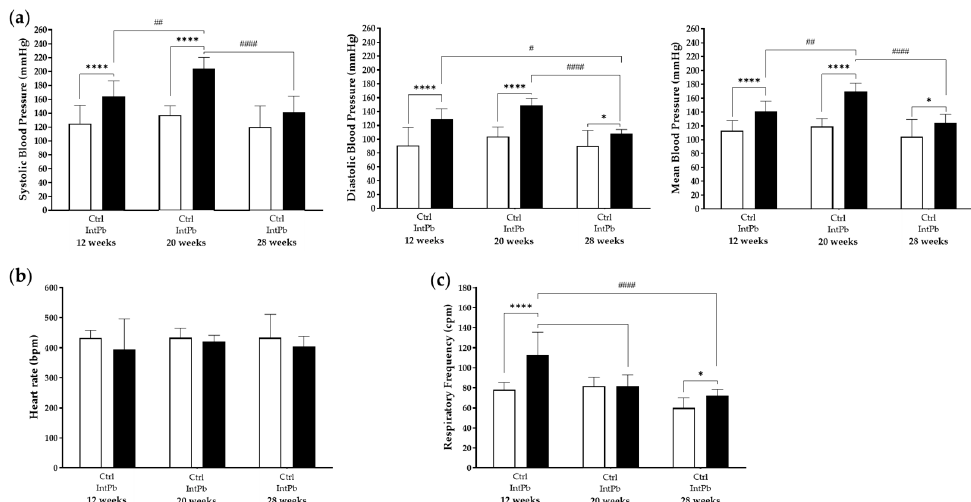
Figure 3. Cardiovascular and respiratory parameters evaluated along the three timepoints. ( a ) Systolic, diastolic, and mean blood pressure assessed from the femoral artery. ( b ) Heart rate values were calculated from the electrocardiogram. ( c ) Respiratory rate calculated from basal tracheal pressure. Values are expressed as the mean ± SD for n IntPb = 12 and n Ctrl = 12 for each evaluated time ‐ point. The symbols denote statistically significant differences inter (Ctrl vs. IntPb—* p < 0.05; **** p < 0.001) and intra groups (IntPb 12w vs. IntPb 20w vs. 28w—# p < 0.05, ## p < 0.01, #### p < 0.0001); two ‐ way ANOVA, Tuckey’s multiple comparison test.